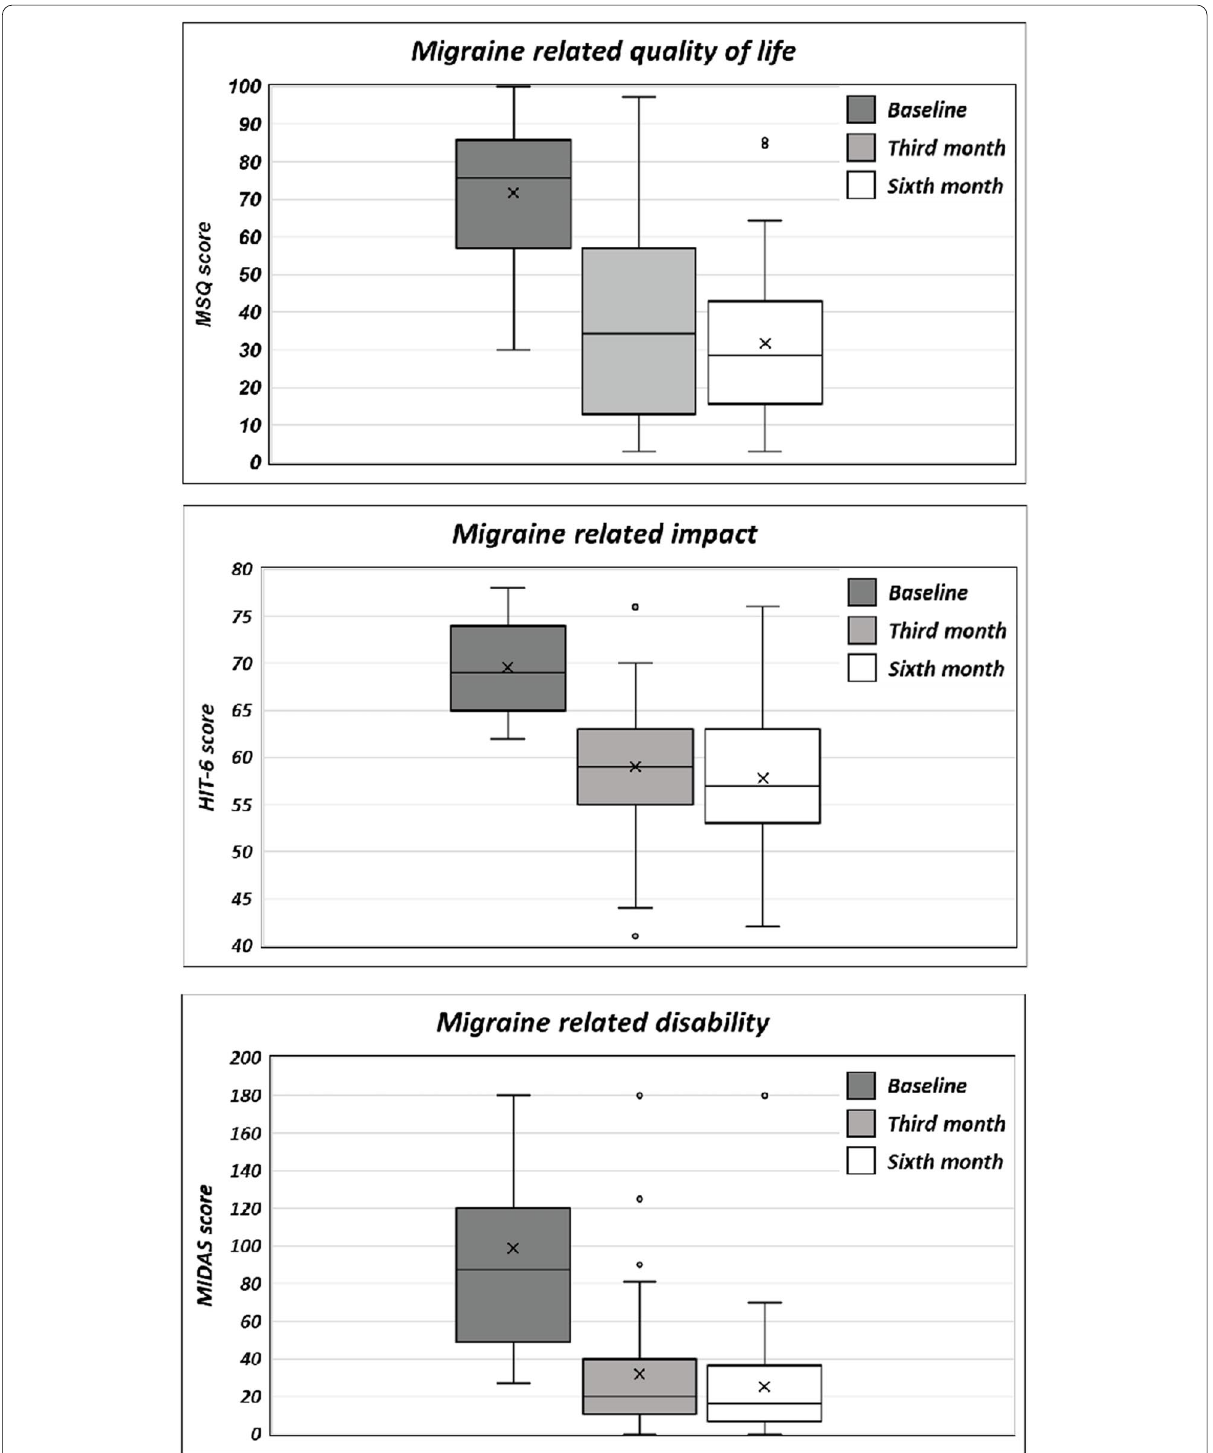
Fig. 3 Migraine-related disability, impact on daily living and quality of life scores at baseline (T 0 ), and at the end of the third (T 1 ) and of the sixth month (T 2 ) of galcanezumab